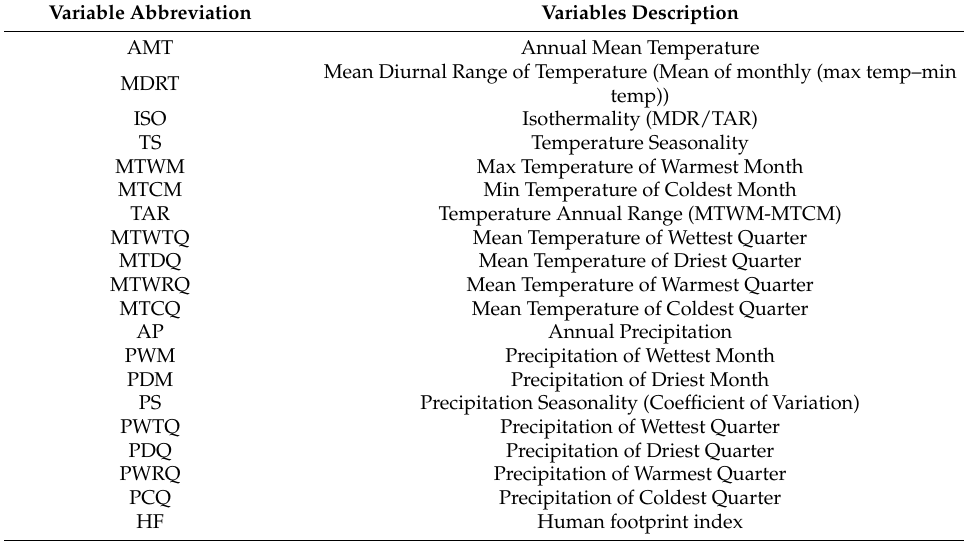
Table 1. Climate variables and a human footprint index that used for developing the MaxEnt models.